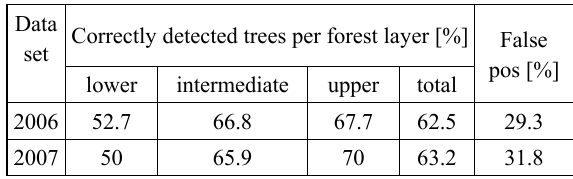
Table 5. 3D Detection of single trees in the sample plots using